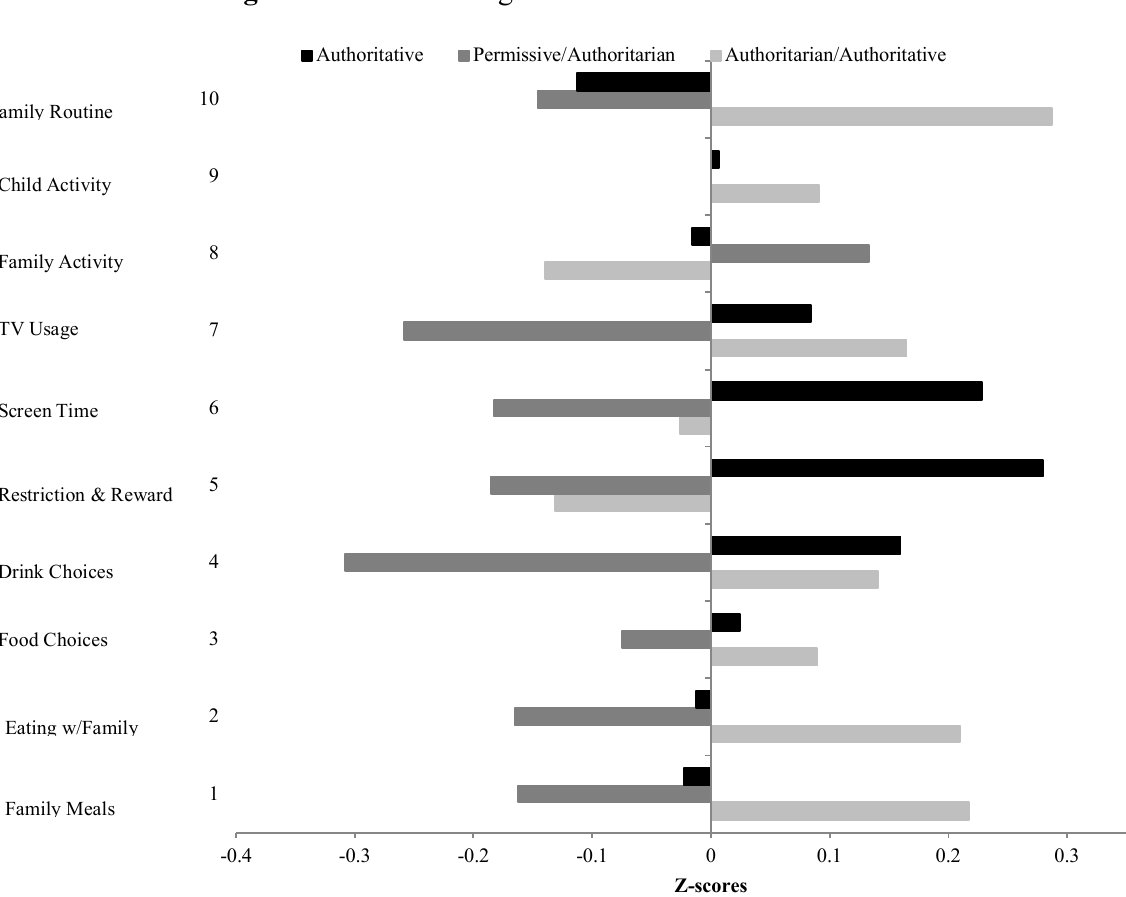
Figure 2. Cluster average z-scores in individual FNPA